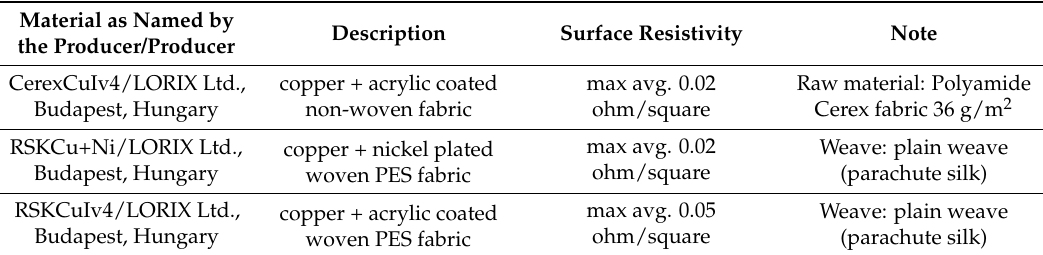
Table 1. Specifications of the used commercial polymer coated fabrics [20].